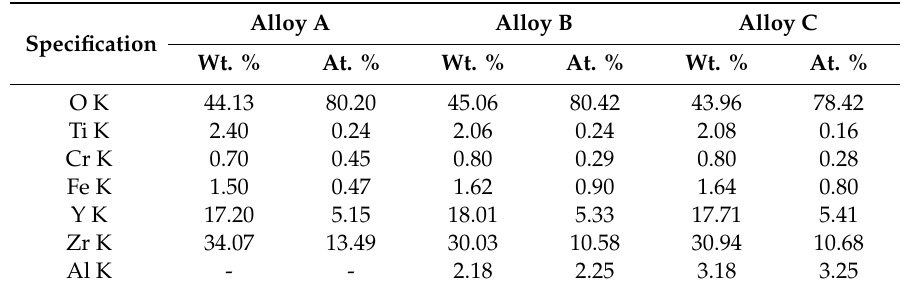
Table 4. Chemical content of the complex oxide particles—II (from the transmission electron microscopy images) for the alloys: Alloy A, Alloy B, and Alloy